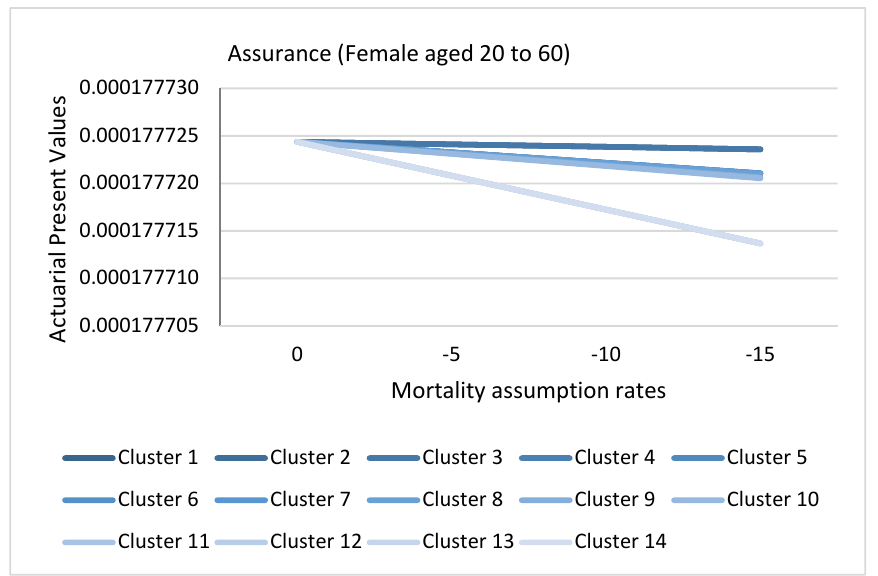
Figure 22. APV for males aged 20 to 60 clusters against mortality assumption rates.